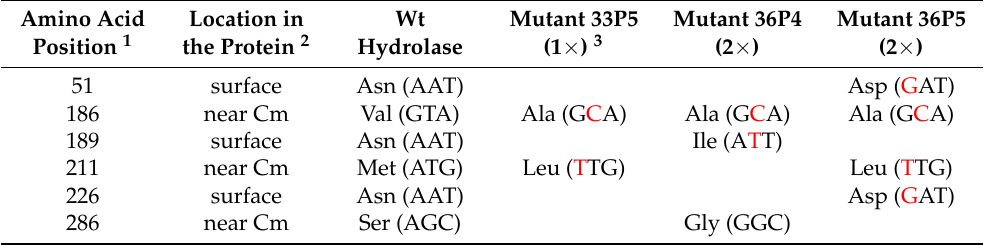
Table 1. Overview of the amino acid mutations found in the selected hydrolase variants. Listed are the amino acids and the corresponding codons in parentheses.